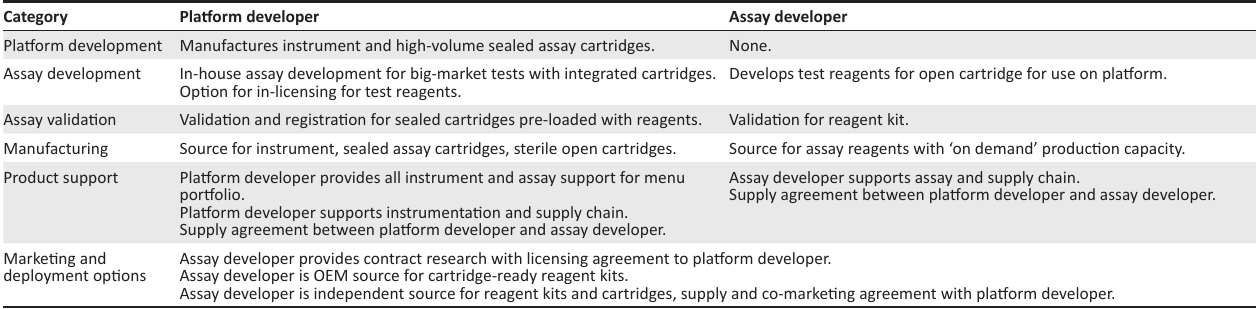
TABLE 3: Co-development roles for open-source model.